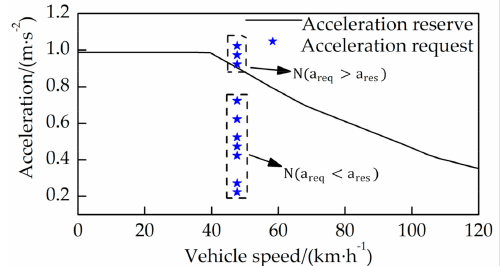
Figure 8. Analysis of the acceleration request.